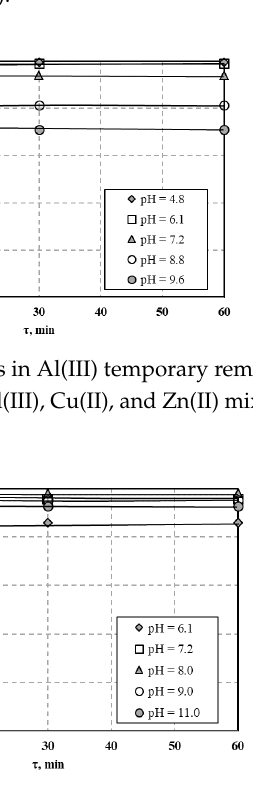
Figure A8. Changes in Cu(II) temporary removal ratio during ion and precipitate flotation from solution containing Al(III), Cu(II), and Zn(II) mixture—effect of pH (c 0 = 0.15 mmol dm − 3 , c SDS = 0.125, u G = 1.51 mm s − 1 ).